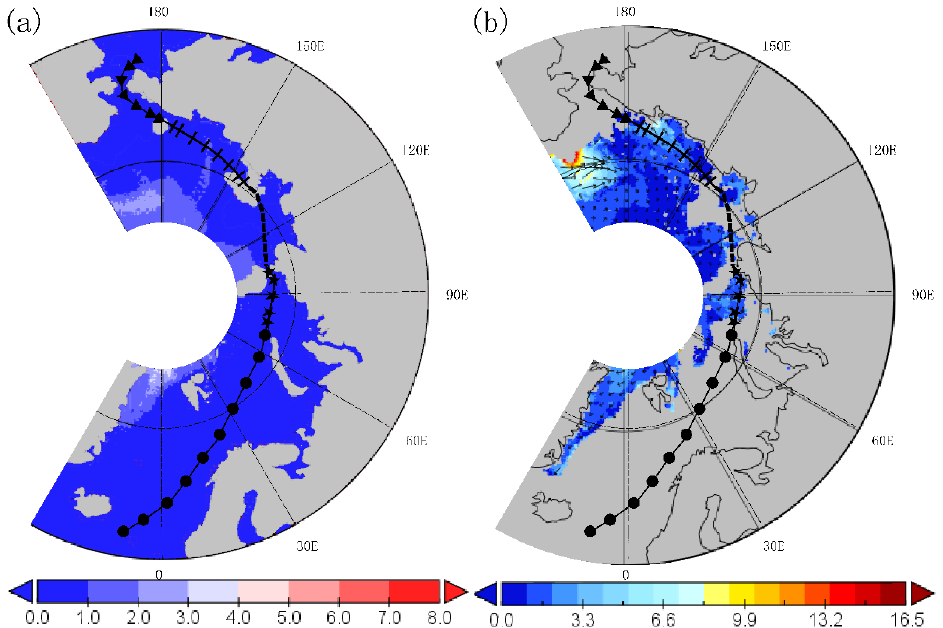
Figure 25. The sea ice age ( a ) and sea ice movement ( b ) of the NEP in the Arctic summer in 2019.